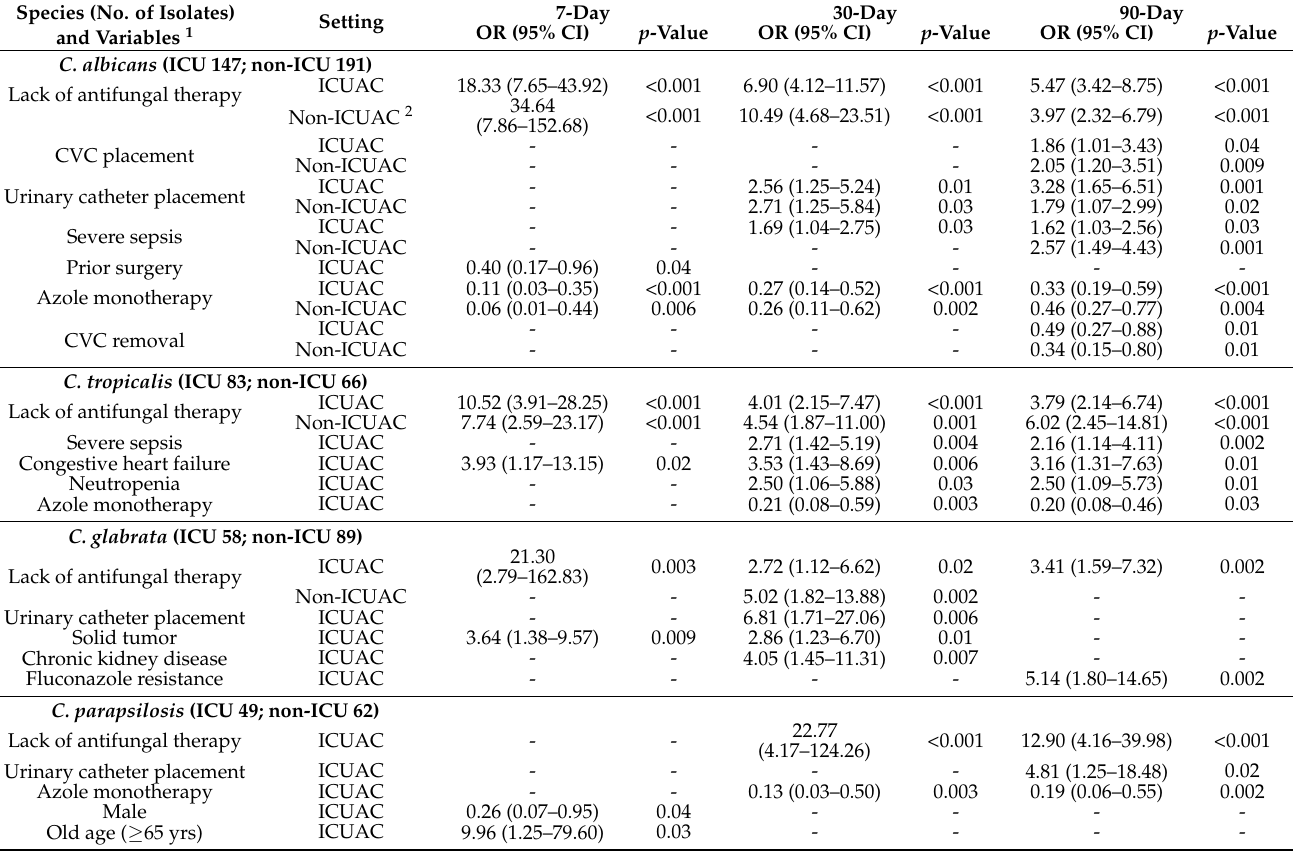
Table 3. Multivariate analysis of predictive factors related to 7-, 30- and 90-day mortalities of patients with ICUAC and non-ICUAC by the four common Candida